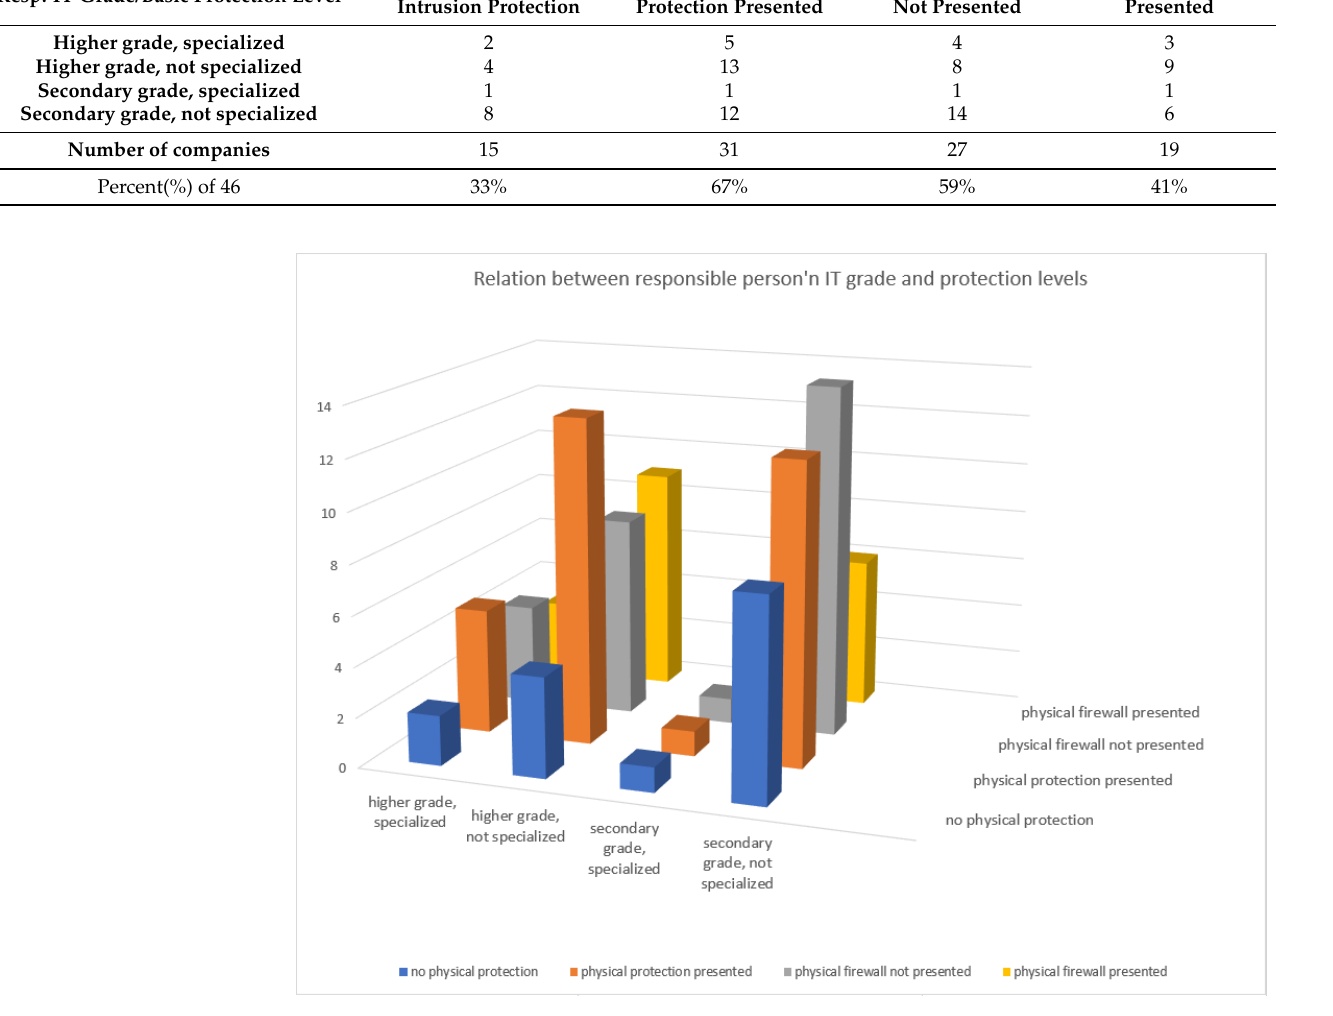
Table 1. Relation between IT grade of decision maker and presented protection level of the company. Resp. IT Grade/Basic Protection Level